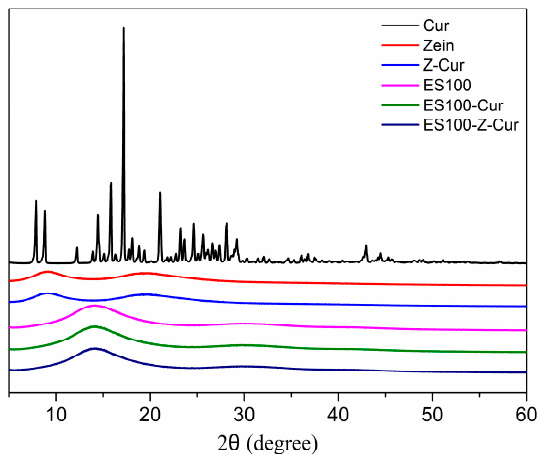
Figure 4. XRD patterns of pure Cur, zein, released self-assembled Z–Cur, ES100, ES100–Cur, and ES100–Z–Cur.